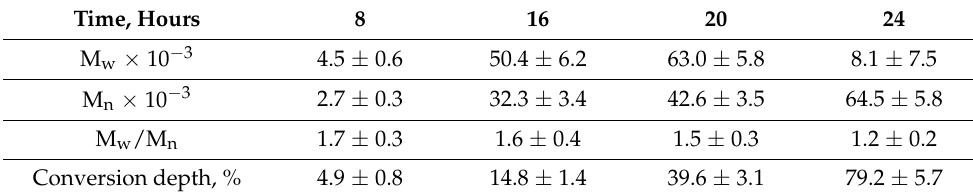
Table 2. Conversion depth and molecular weight characteristics during PLA synthesis.